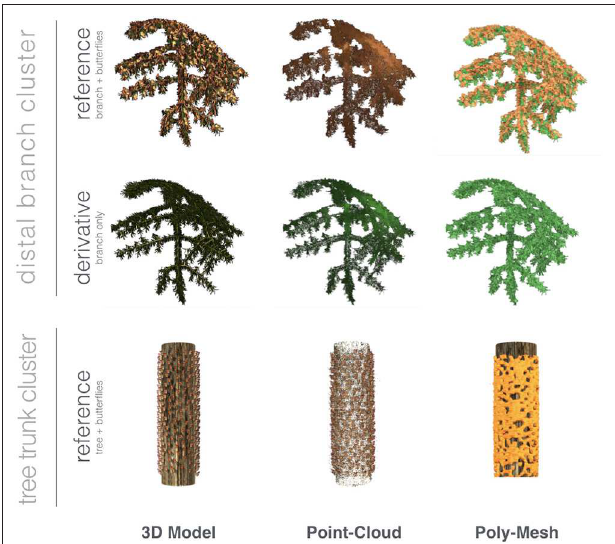
FIGURE 5 | Examining the steps of TLS/SVE processing using virtual models of an Oyamel fir distal branch and tree trunk examples. In each case, a virtual 3D model is surveyed using virtual photogrammetry to create a point-cloud representation. That data is converted to a polygonal model that is suitable for quantitative analysis. In the distal branch example, shown are the data for the reference scan, including the branch with butterflies and derivative scan of the branch without butterflies. These quantitatively accurate models are used to validate the results from the TLS estimation of real-world butterfly aggregations.